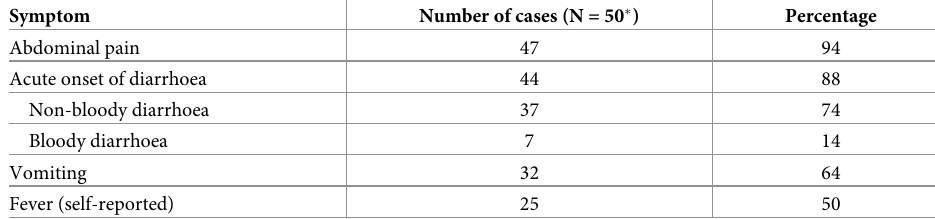
Table 2. Distribution of symptoms of suspected cases of gastrointestinal anthrax during an outbreak: Isingiro, Uganda, August 2017.